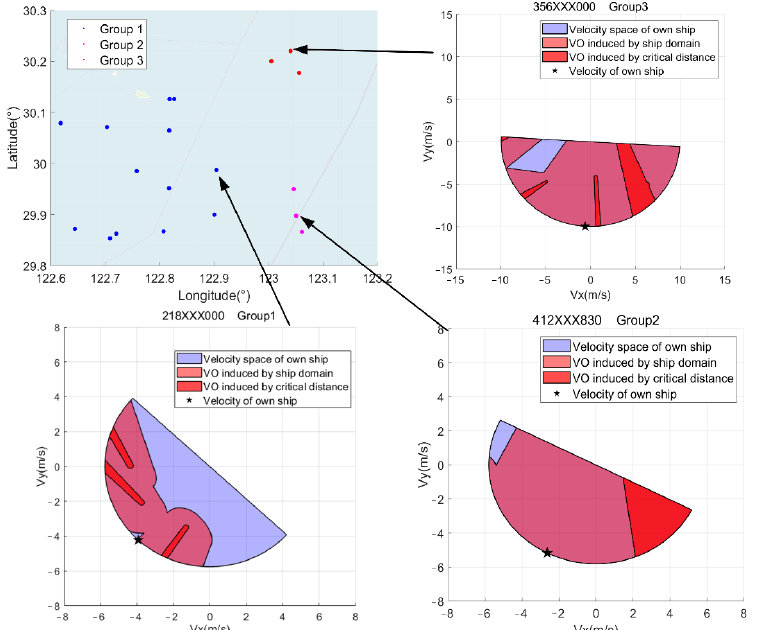
Figure 6. Visualization of ship clustering and TCR of random ship in the groups at 16:13:45.